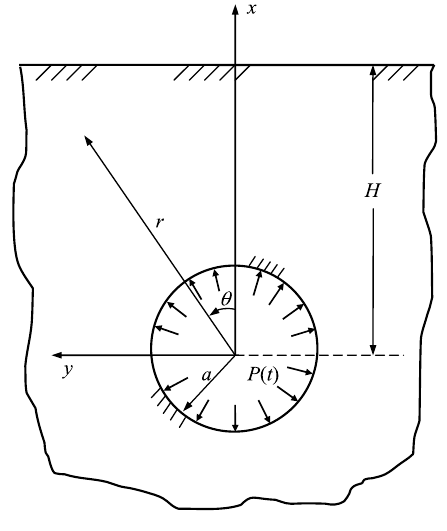
Fig. 1. Cylindrical cavity embedded in a